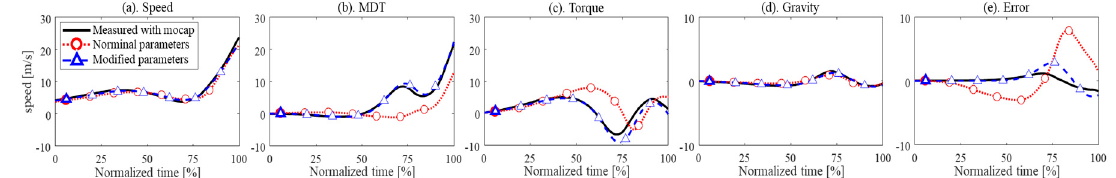
Figure 4. Time curves of the contributions of individual terms to the ball speed, where the titles in Figure 4a,c are as follows; speed: measured ball speed; torque: total contribution of joint torque